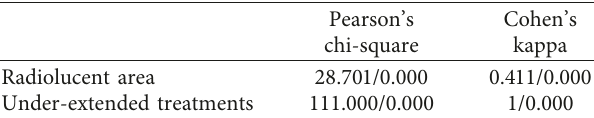
Table 3: Statistical analysis: association between CBCT and intraoral Rx results in diagnosis of radiolucent areas and under- extended